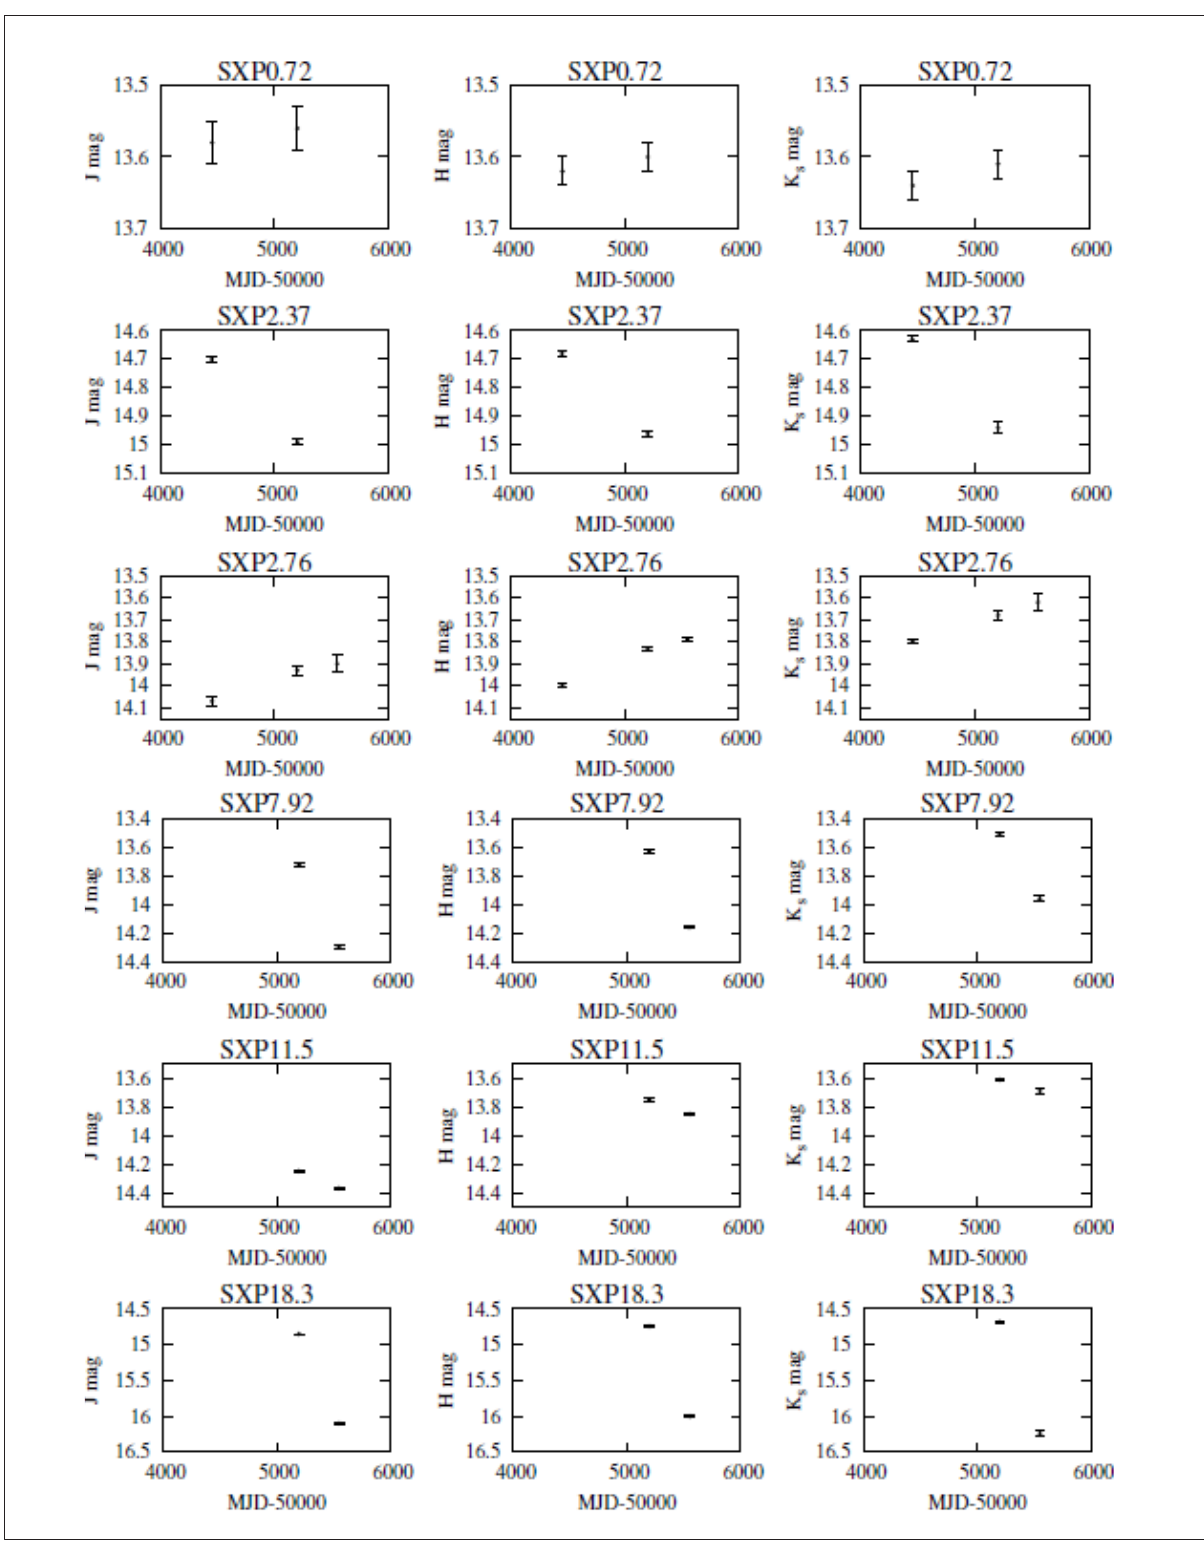
Figure 3: Lightcurves for six Be/X-ray binaries in the Small Magellanic